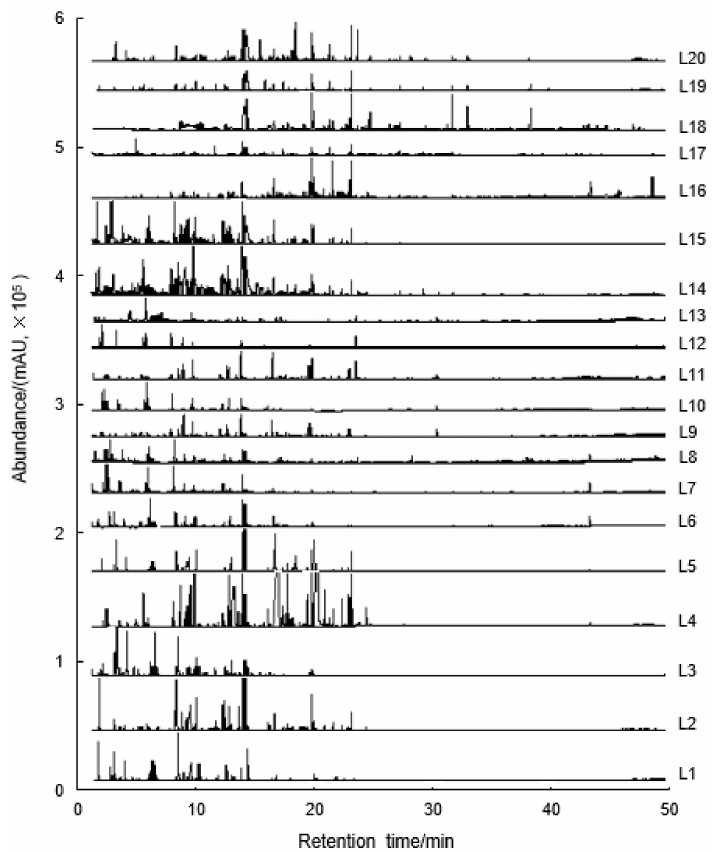
Figure 1. Total ion chromatograms of volatile compounds of virgin Camellia oleifera seed oil (VCO) from 20 geographic